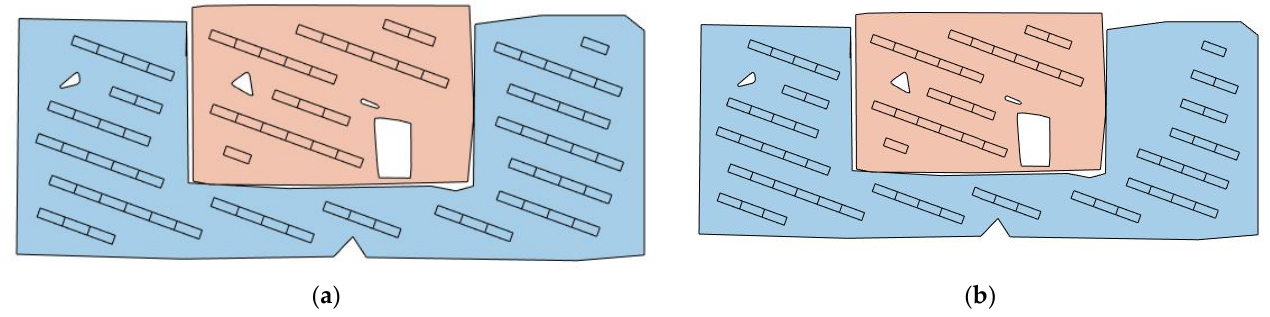
Figure 17. Comparison of PV module layout for the ADMIN building ( a ) without and ( b ) with shading analysis.